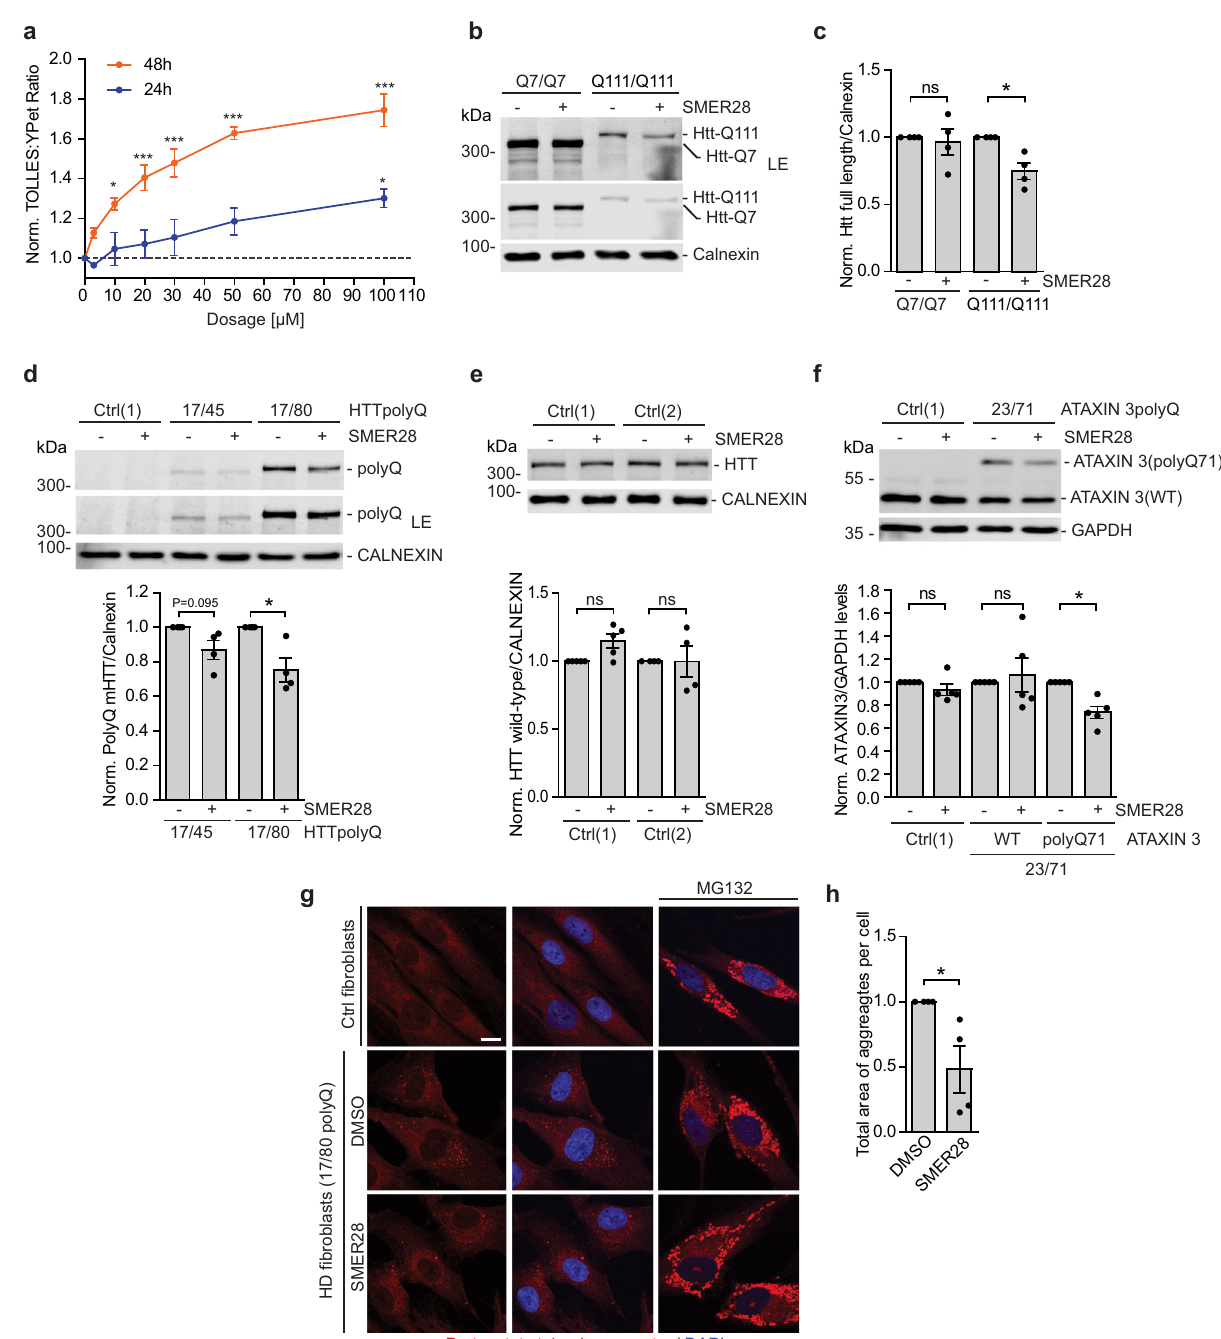
Fig. 1 SMER28 induces autophagy fl ux and clears mutant neurodegeneration-causing proteins. a HeLa cells expressing SRAI-LC3B were treated with a series of SMER28 concentrations (3 µ M, 10 µ M, 20 µ M, 30 µ M, 50 µ M, and 100 µ M) or DMSO for 24 h or 48 h and analyzed by FACS; one-way ANOVA for 48 h: P < 0.0001 (10 µ M P = 0.0097, 20 µ M P = 0.003, 30 – 100 µ M P < 0.0001) and for 24 h: P = 0.0264 (100 µ M P = 0.0187) with post hoc Tukey test, n = 3. b , c Mouse striatal cells expressing wild-type (Q7/Q7) or mutant (Q111/Q111) huntingtin were treated with 20 µ M SMER28 for 24 h. Cells were lysed and analyzed by western blotting with anti-huntingtin antibody, n = 4; quanti fi cation in c (Q7/Q7 P = 0.7384, Q111/Q111 P = 0.0262). d , e Control (Ctrl) and Huntington ’ s Disease (HD) fi broblasts expressing mHTT-polyQ45 or mHTT-polyQ80 were treated with 20 µ M SMER28 for 24 h. Cells were lysed and analyzed by western blotting with anti-polyQ ( d , n = 4; HD17/45 P = 0.0953; HD17/80 P = 0.0355) or anti-huntingtin antibody ( e n = 5). f Control (Ctrl) and Spinocerebellar ataxia type 3 (SCA3) fi broblasts were treated with 30 μ M SMER28 for 24 h. Cells were lysed and analyzed by Western blotting with anti-Ataxin 3 antibody, n = 5; Ctrl1 P = 0.2491, WT P = 0.6842, polyQ P = 0.0075. g , h Control or HD fi broblast cells expressing mHTT- polyQ80 were treated with DMSO, 20 µ M SMER28 or 1 μ M MG132 as control. Cells were fi xed and stained with Proteostat dye. Total area of aggregates puncta was quanti fi ed in h ; n = 4, P = 0.497; scale bar = 10 μ m. Bar graphs data presented as normalized mean ± SEM. * P < 0.05, ** P < 0.001, one sample t test unless stated otherwise; LE long exposure, WT wild-type, HTT, Huntingtin, Ctrl control cells, ns not signi fi cant. Source data are provided as a Source Data fi